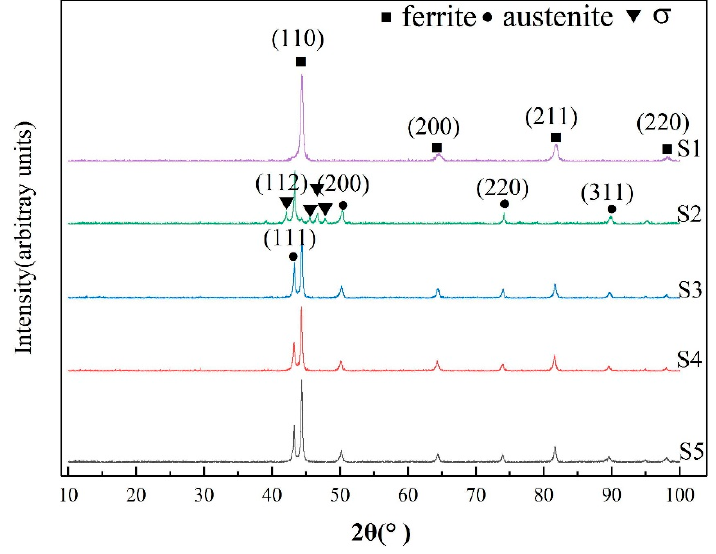
Figure 1. The XRD diagrams of samples processed by different technologies.